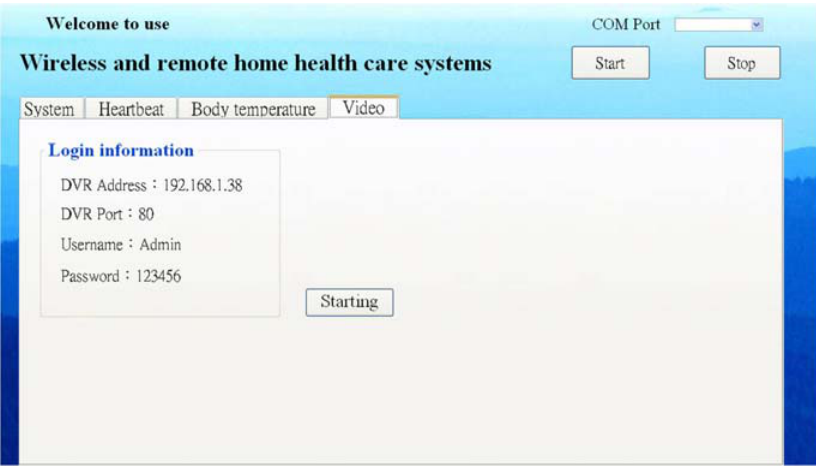
Figure 7. Visual